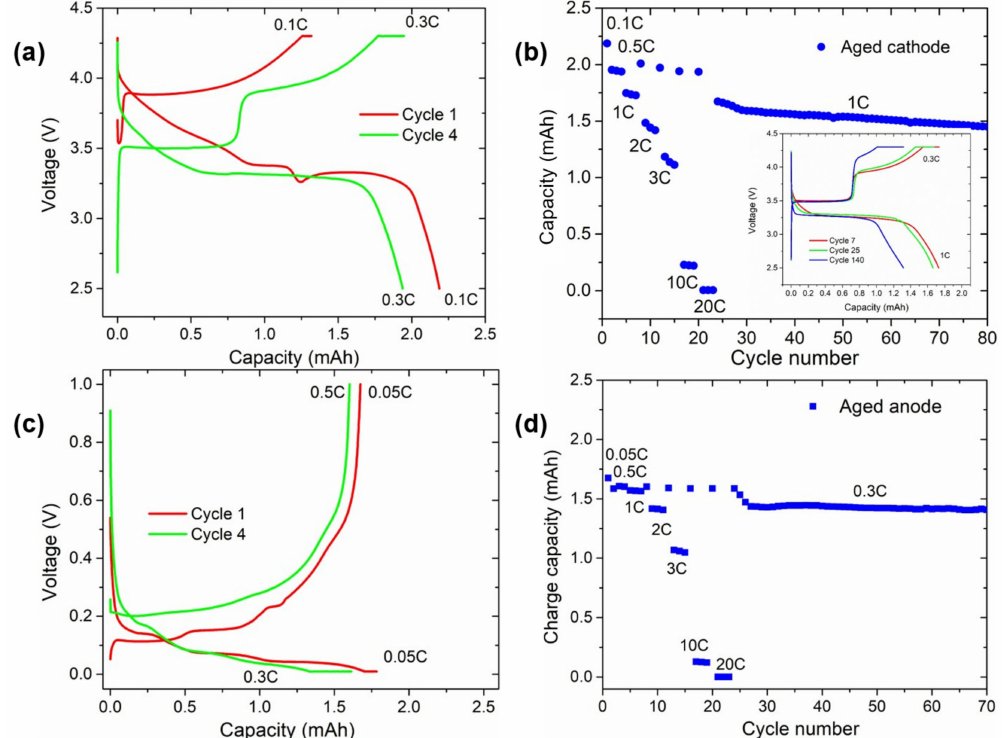
Figure 6. Comparison of the voltage profile and subsequent rate capability test from aged ( a , b ) cath- odes and ( c , d ) anodes. Red and green galvanostatic curves correspond to cycles number 1 and 4, respectively. The inset in ( b ) shows the voltage vs. capacity curve of these cells for cycles 7 (red line), 25 (green line), and 140 (blue line) at 1 C discharge and 0.3 C charge